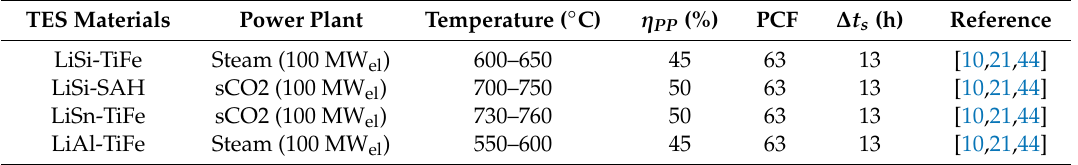
Table 4. Baseline solar power plant configuration